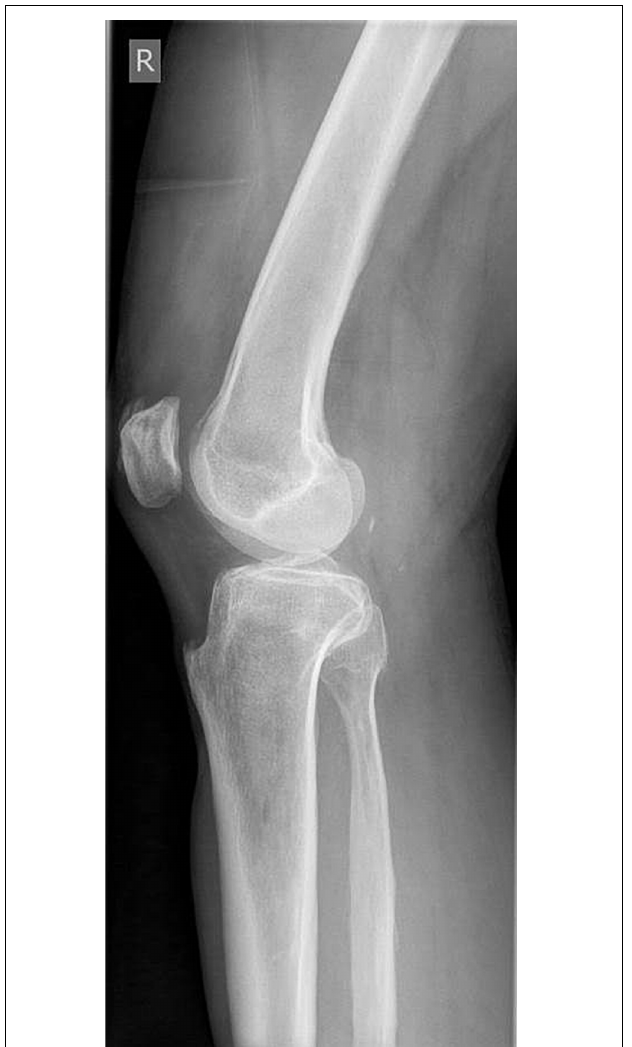
FIGURE 1 | X ray of the right knee.